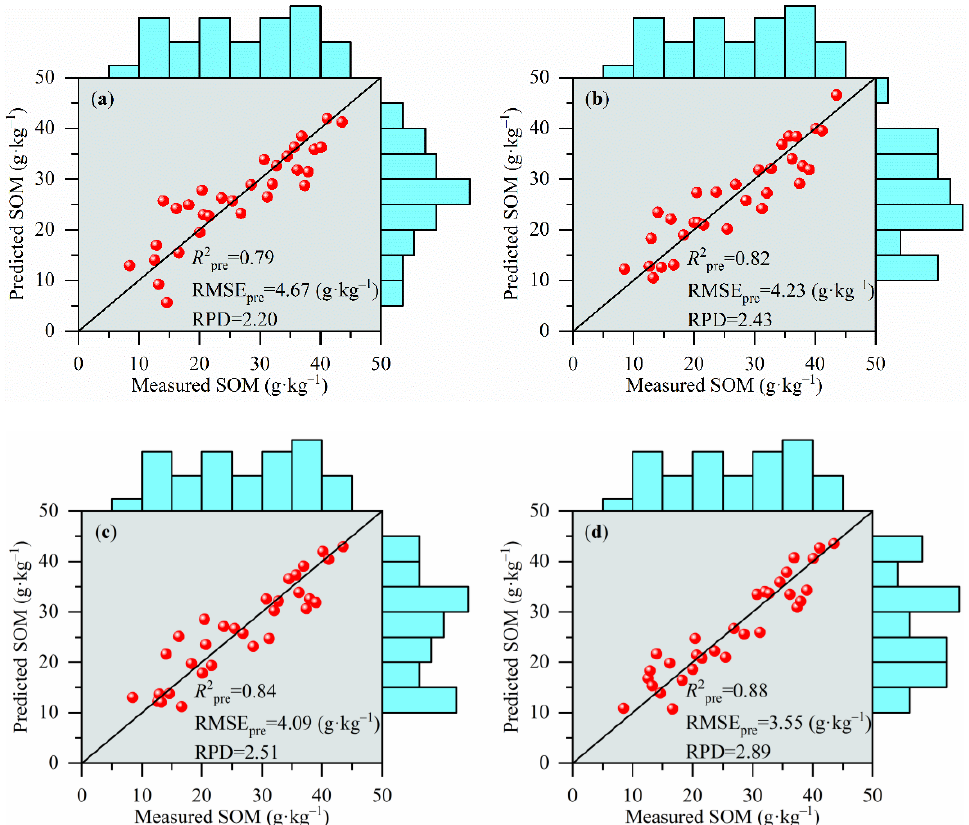
Figure 11. Scatter plots of measured SOM and predicted SOM for different variable selection methods: ( a ) full-spectrum (1.5-order derivative spectra); ( b ) CARS (1.25-order derivative spectra); ( c ) ENET (1.25-order derivative spectra); and ( d ) GA (1.5-order derivative spectra). The regression statistics ( R 2pre , RPD) of validation dataset are illustrated in the lower right corner of the four subplots. The black lines denote as the 1:1 line.